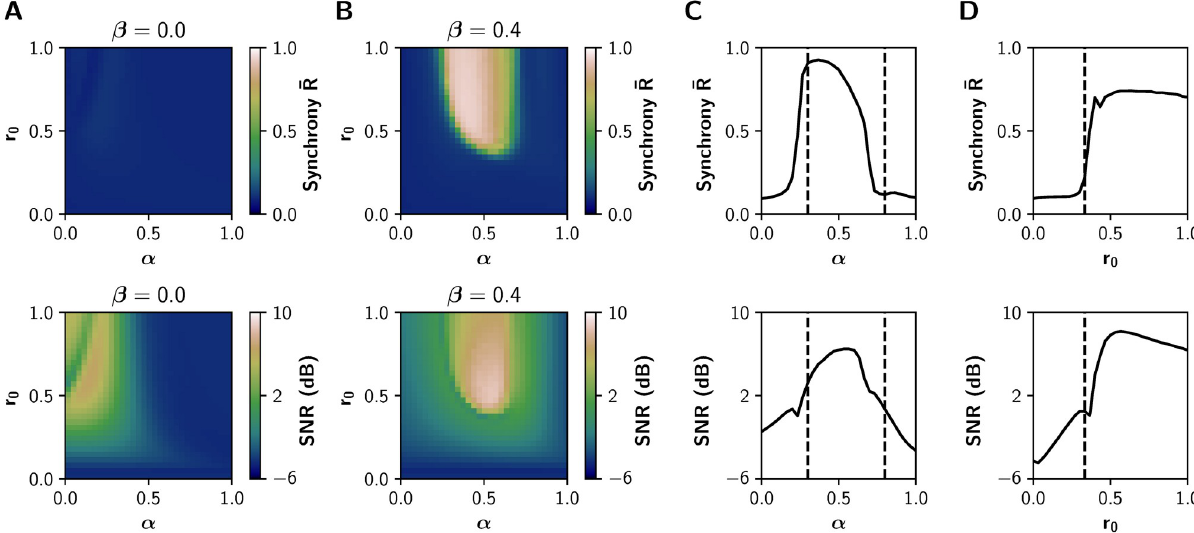
Fig 5. EEG features in the ( α , r 0 ) parameter space. A-B) Average phase synchrony � R and signal-to-noise ratio (SNR) measured from the EEG-like signals. A) No action of inhibitory gain ( β = 0). B) The increase of � R and the SNR matches with functional integration for β = 0.4. C) Transitions through the critical boundary in the α axis, with a fixed r 0 = 1 mV − 1 . Critical transitions represented by black dashed lines at α = 0.3 and α = 0.8. D) Transitions in the r 0 axis, for a fixed α = 0.6, with a critical transition at r 0 = 0.33 mV − 1 .